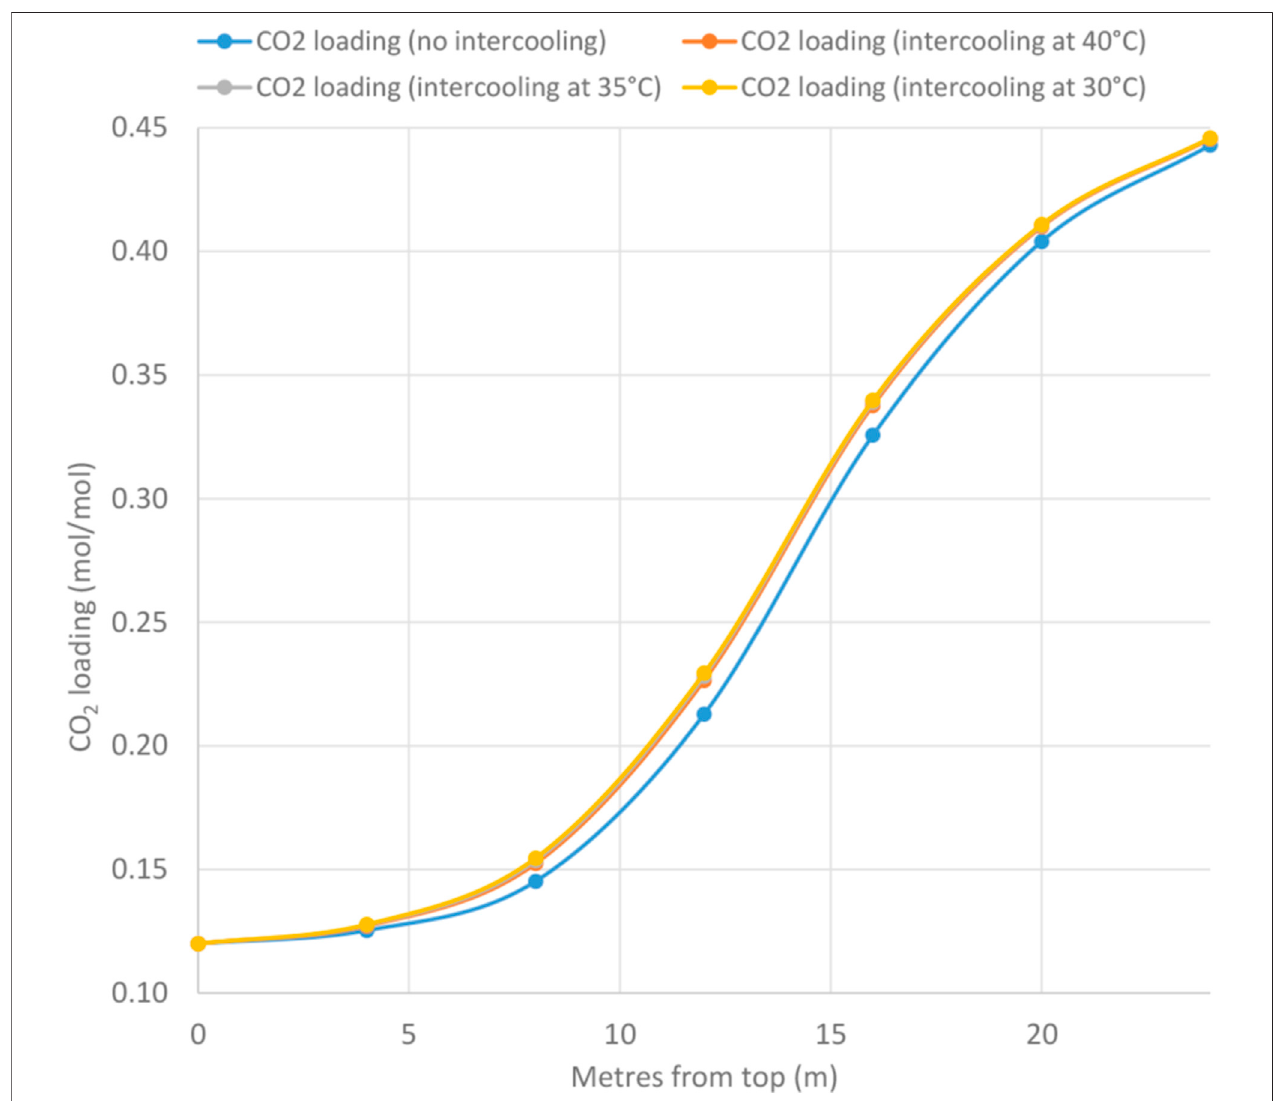
FIGURE 11 | Increase in CO 2 loading along the absorber for 24 m packing height, 99% capture level, and lean loading of 0.12 molCO 2 /molMEA.